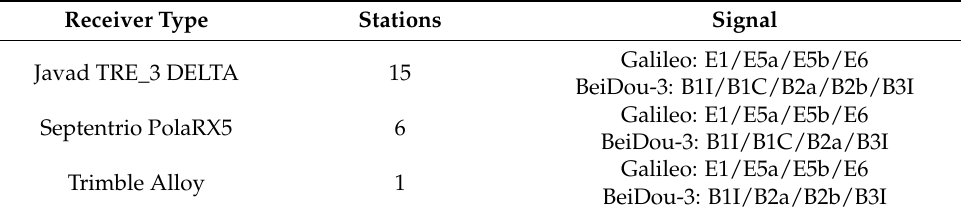
Table 2. Receiver details of stations used in this study.